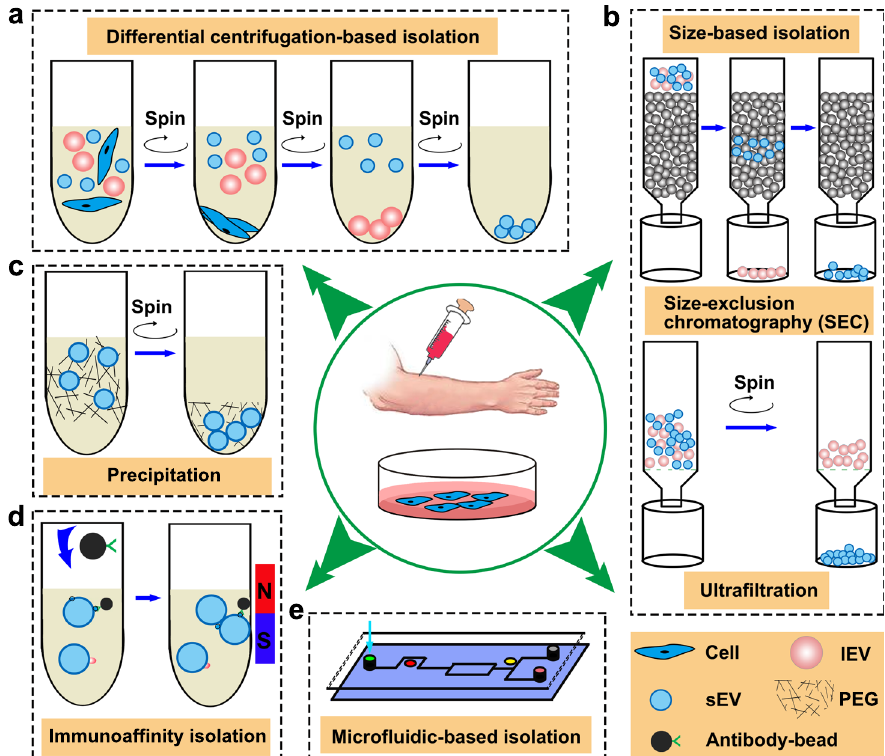
Fig. 2 The isolation methods of sEVs. Isolation methods of sEVs were divided into differential centrifugation-based isolation ( a ), size-based isolation technique ( b ), precipitation ( c ), immunoaf fi nity isolation ( d ) and micro fl uidic-based isolation ( e